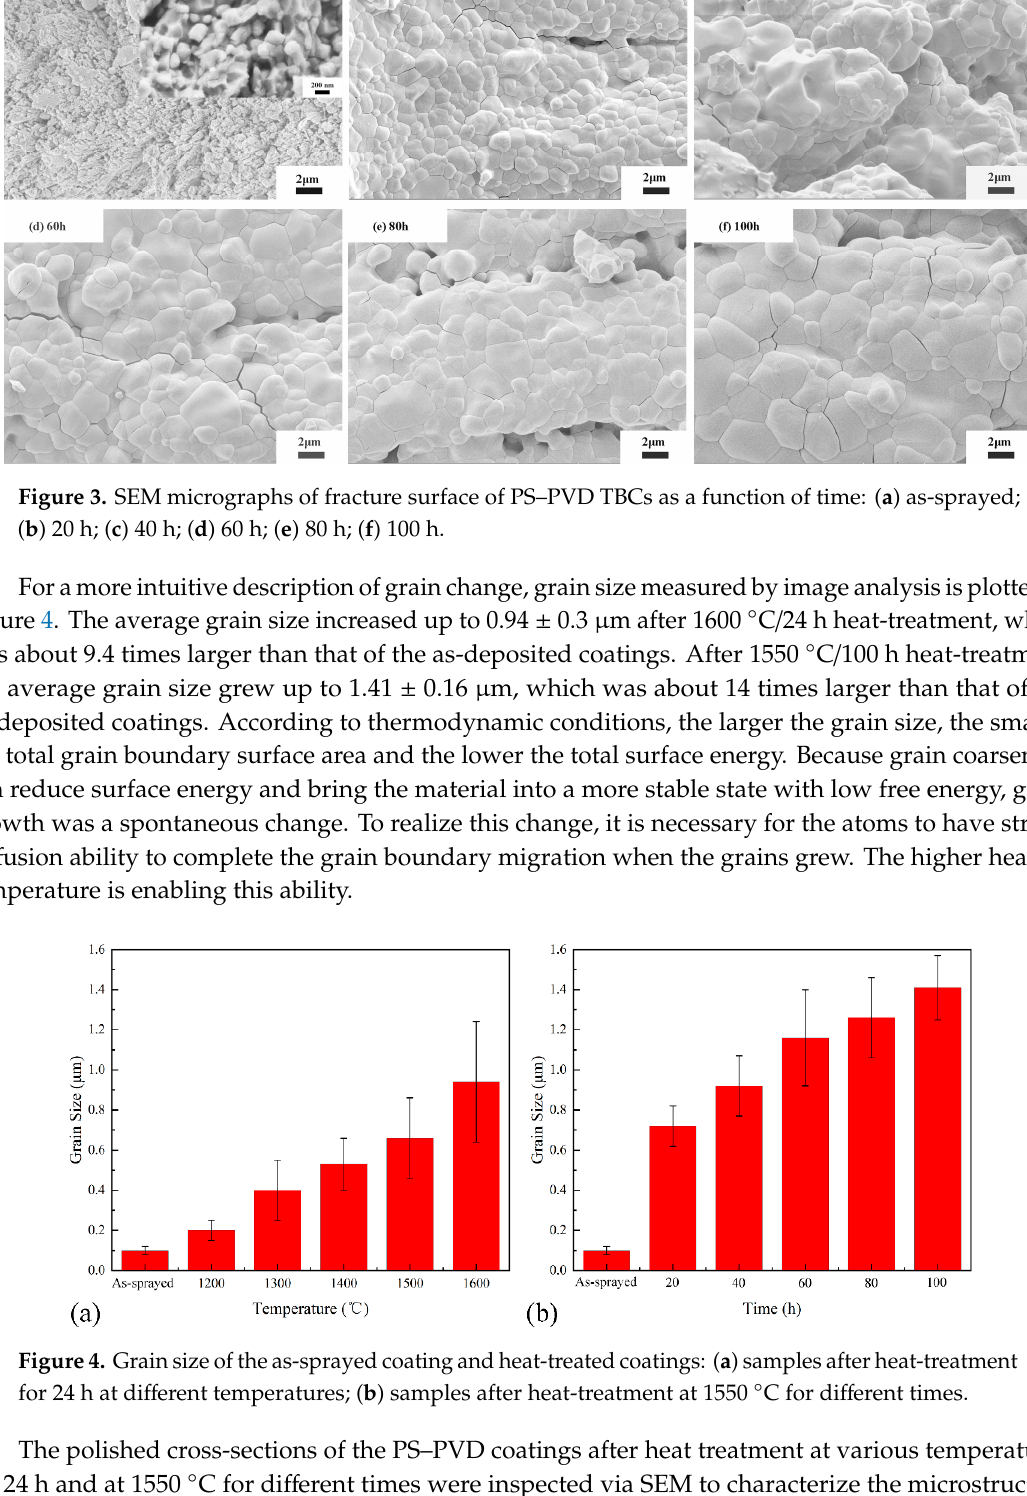
Figure 2. SEM micrographs of fracture surface of PS–PVD TBCs as a function of temperature: ( a ) as-